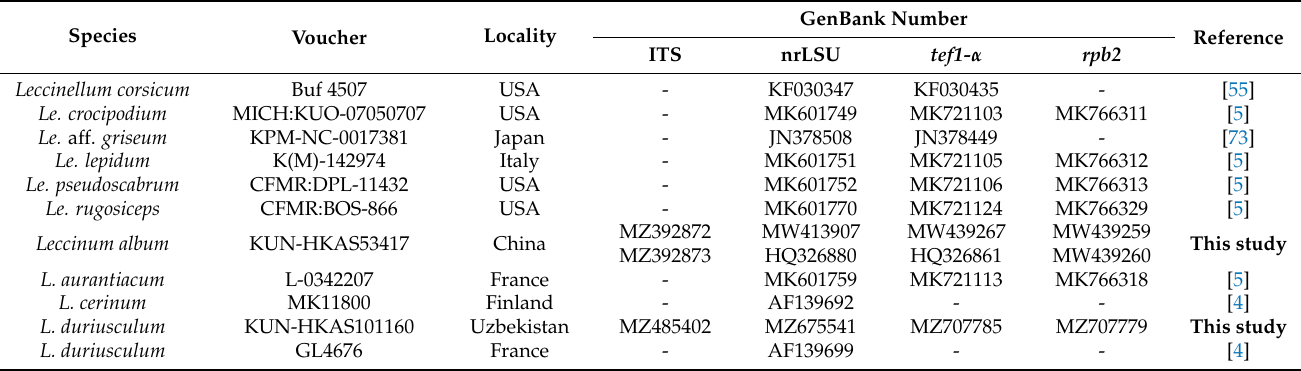
Table 1. Information on specimens used in multi-locus phylogenetic analyses and their GenBank accession numbers. Sequences newly generated in this study are indicated in